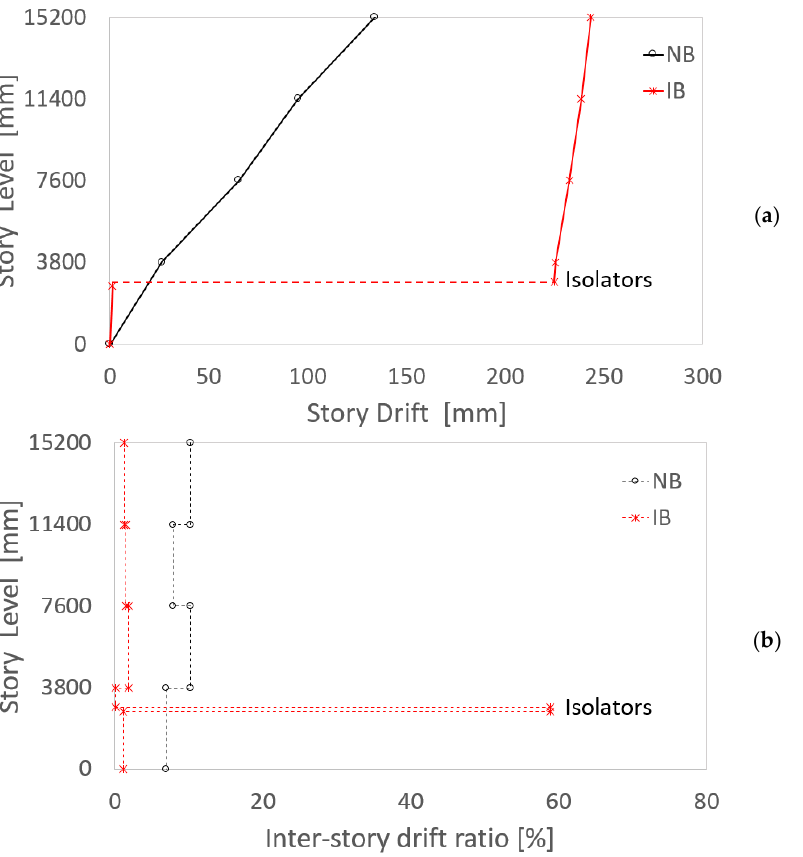
Figure 18. Example of numerically calculated drift for the centre of mass of the non-isolated (NB) or isolated (IB) building system (Midas): ( a ) story drift and ( b ) inter-story drift ratio.